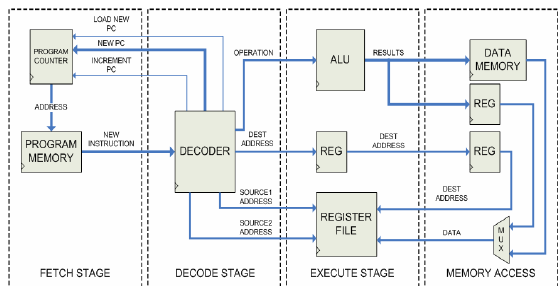
Figure 4. Increase in IPC for a 4-stage processor compared to a 3-stage